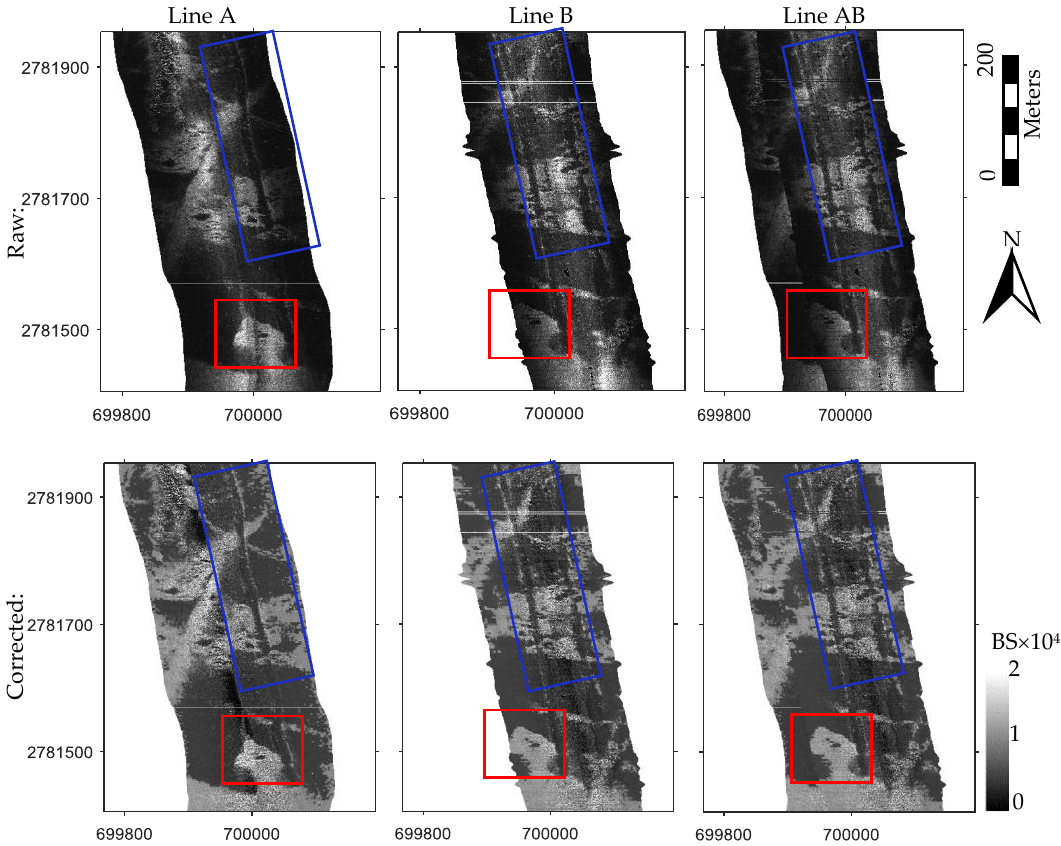
Figure 15. Consistency analysis of sediment variations. Lines A and B are two adjacent SSS lines, and Line AB is their mosaic image. The red rectangle denotes the peach-like shape of sediment distribution, and the blue one shows the shapes and positions of two submarine pipelines. The white lines between pings are caused by data losses. The location coordinates are same as Figure